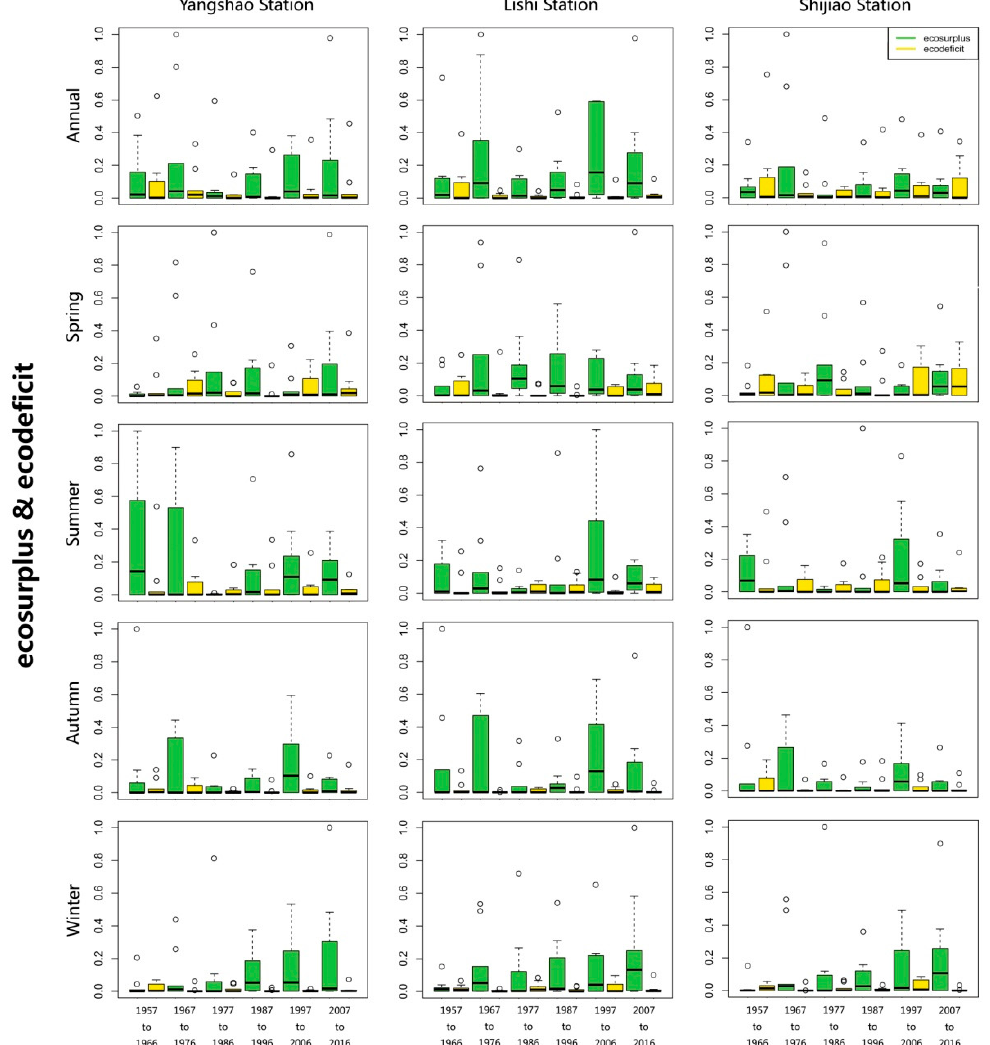
Figure 4. Decadal variations of eco-flow indicators in annual or seasonal time scales.